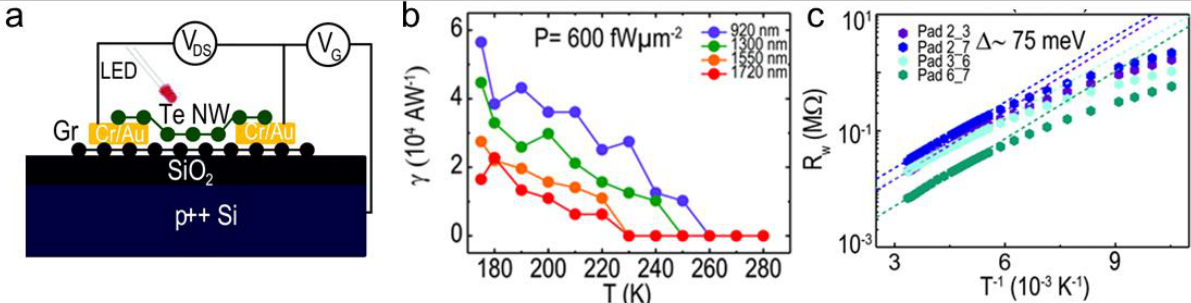
Figure 6. Cooling-enhanced phenomenon on photogating photodetectors. ( a ) The structure of photogating Te NW devices. ( b ) The temperature-dependent responsivity of Te NW devices. Reproduced with permission. ( c ) The temperature dependent-resistance of Te NW devices (adapted from [80], with permission from the Royal Society of Chemistry, 2017).